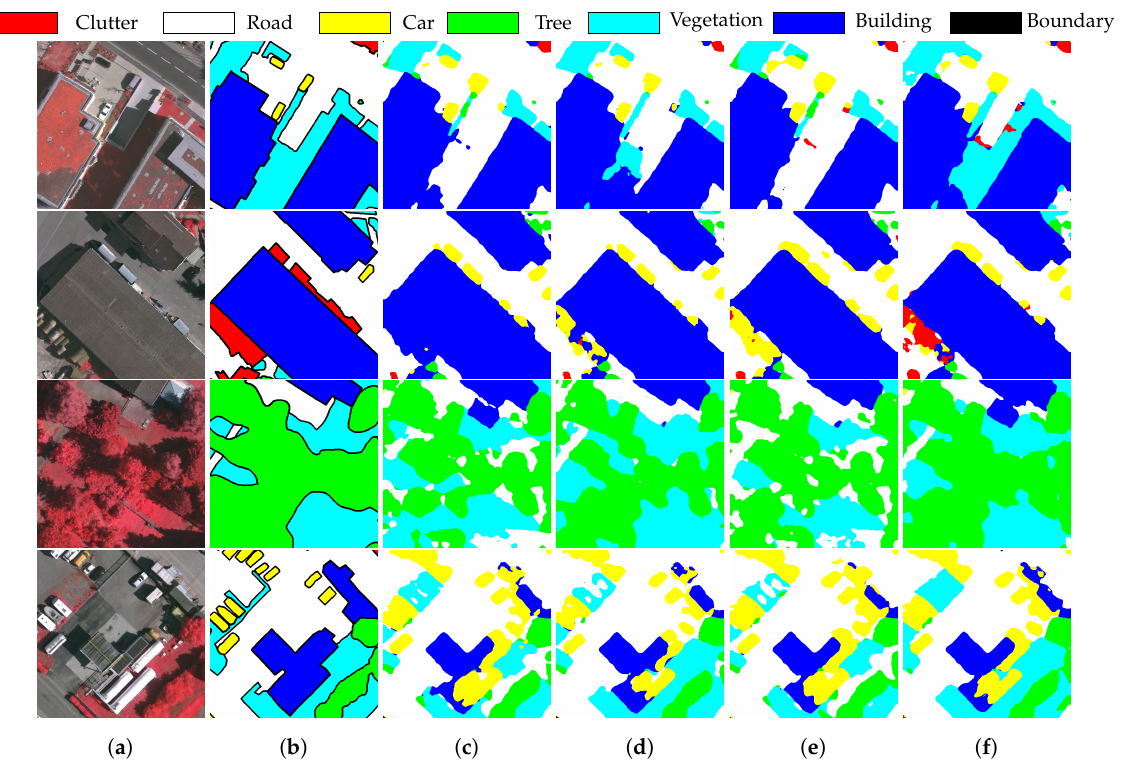
Figure 4. Predictions of the validation images from VAI on POT → VAI. ( a ) Target images. ( b ) Ground truth. ( c ) Baseline. ( d ) Baseline with GCW. ( e ) Baseline with LDQ. ( f ) Baseline with GCW and LDQ.